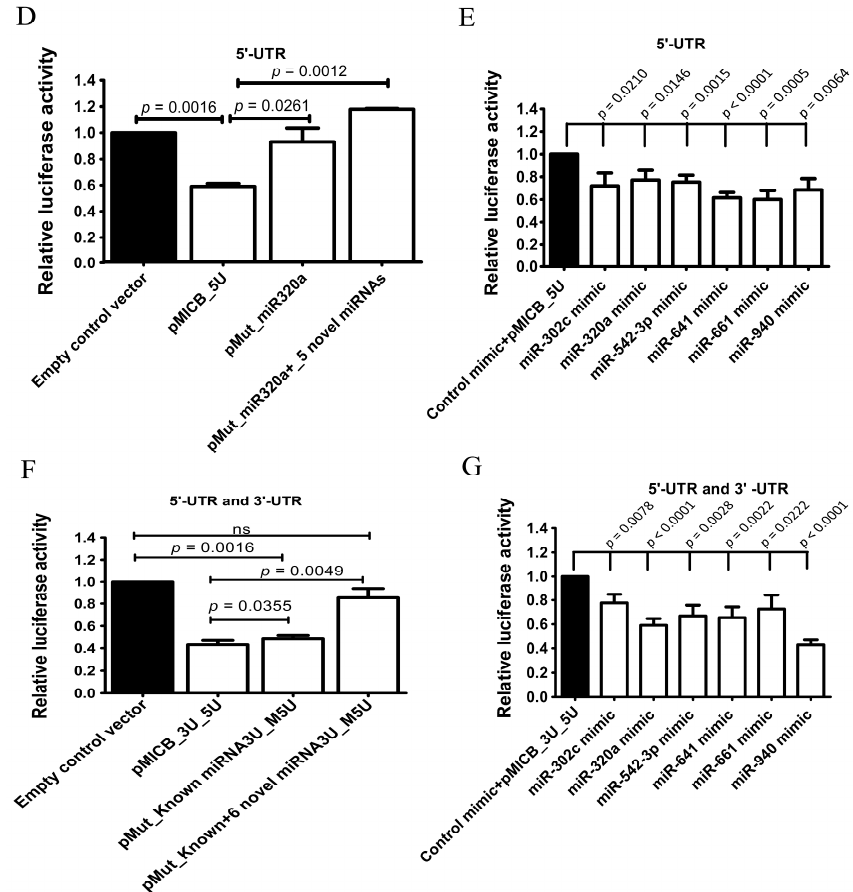
Figure 3 . Candidate miRNAs directly interacted to 3’ - UTR and 5’ - UTR of MICB. ( A ) The predicted binding sites of candidate miRNAs were mutated by PCR directed mutagenesis and were confirmed by DNA sequencing as shown; ( B ) Relative luciferase activity after transiently transfected with a luciferase reporter fused to a 3 ′ - UTR of MICB ( pMICB_3U ) , the mutated 3 ′ - UTR of MICB for the binding sites of known miRNAs ( pMut_Known miRNAs_3U ) , the mutated 3 ′ - UTR of MICB for the binding sites of both known miRNAs and novel miRNAs ( pMut_Known + 6 Novel miRNAs_3U ) or luciferase gene alone ( empty control vector ) into 293T cells; ( C ) Relative luciferase activity after overexpressing candidate miRNAs in 293T cell and co - transfected with a luciferase reporter fused to a 3 ′ - UTR of MICB ( pMICB_3U ) ; ( D ) Relative luciferase activity after transiently transfected with a luciferase reporter fused to a 5 ′ - UTR of MICB ( pMICB_5U ) , a mutated binding site of only miR - 320a ( pMut_320a ) , a mutated binding sites of all candidate miRNAs ( pMut_miR320a + 5 Novel miRNAs ) or luciferase gene alone ( empty control vector ) into 293T cells; ( E ) Relative luciferase activity after overexpressing candidate miRNAs in 293T cell and co - transfected with a luciferase reporter fused to a 5 ′ - UTR of MICB ( pMICB_5U ) ; ( F ) Mutated binding sites of only candidate miRNAs on 5 ′ - UTR ( pMut_Known _3U_M5U ) and, mutated both binding sites of known and candidate miRNAs on 3 ′ - UTR and mutated binding sites of only candidate miRNAs on 5 ′ - UTR ( pMut_Known + 6 Novel miRNAs_3U_M5U ) ; ( G ) Relative luciferase activity after overexpressing candidate miRNAs in 293T cell and co - transfected with a luciferase reporter fused to both 3 ′ - and 5 ′ - UTR ( pMICB_3U_5U ). Firefly luciferase activity was normalized with Renilla luciferase activity and subsequently normalized to the activity of control reporter . Results are depicted as mean ± S . E . M, n = 3 experiments .